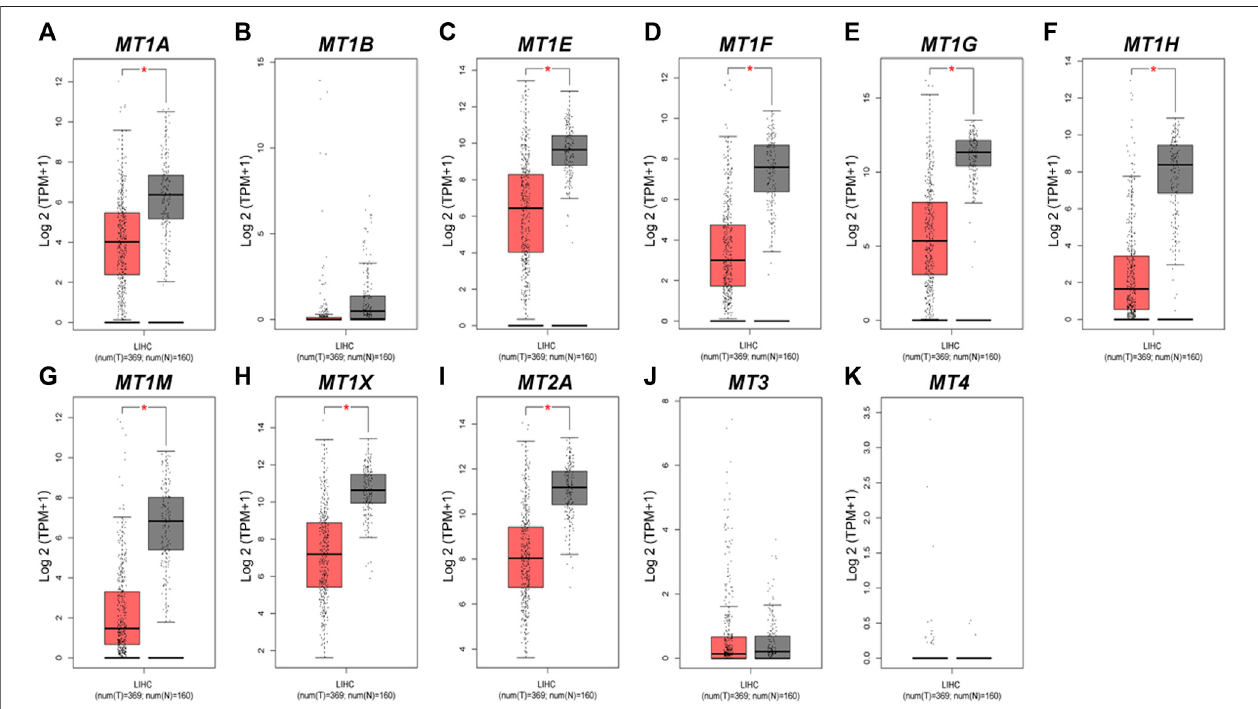
FIGURE 2 | Transcriptional expression levels of MTs in HCC and normal liver tissues from the GEPIA database. (A – K) Expressional comparison of 11 MT family members in HCC (red plot) and normal (gray plot) tissues. * p < 0.01.